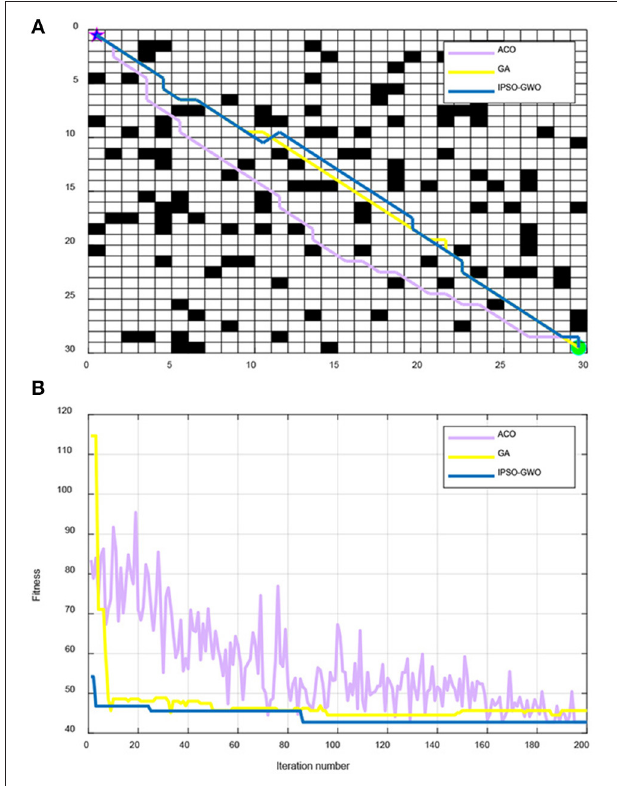
FIGURE 6 | Simulation results of IPSO-GWO, GA, ACO in 20 × 20 map environment. (A) Path comparison with GA, ACO, and IPSO-GWO algorithms. (B) Iterative curve with GA, ACO, and IPSO-GWO algorithms.